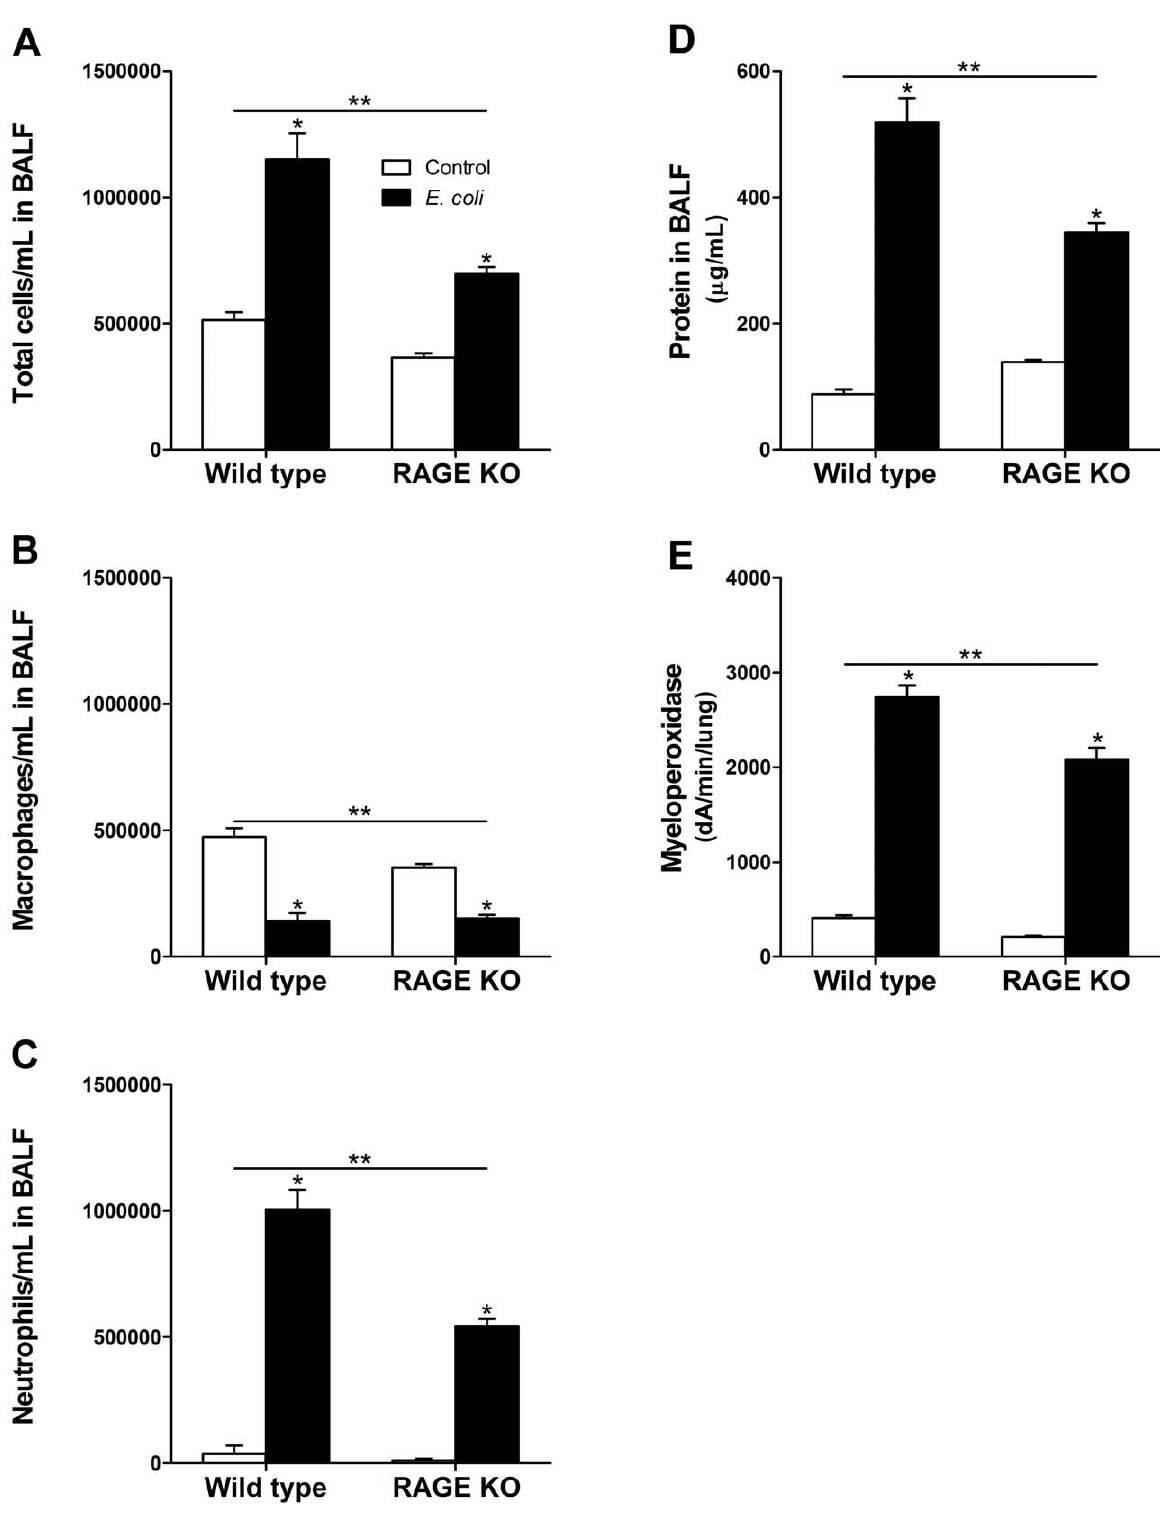
Figure 2. RAGE KO mice get less inflammation than wild type mice after E.coli pneumonia. E. coli challenged RAGE KO mice had significantly less total cells/mL in BALF compared to wild type mice (A). The lower amount of cells was mainly due to less neutrophils (B, C). Protein in BALF (D) and myeloperoxidase activity of whole lung (E) were also significantly less in RAGE KO than in wild type mice after E. coli challenge. * indicate significant increase/decrease compared to vehicle control for each strain. ** indicate significant difference between wild type and RAGE KO mice. Data are mean 6 SEM, analyzed by 2-way ANOVA with a Bonferroni post hoc test ( n of 6–8 per group ).